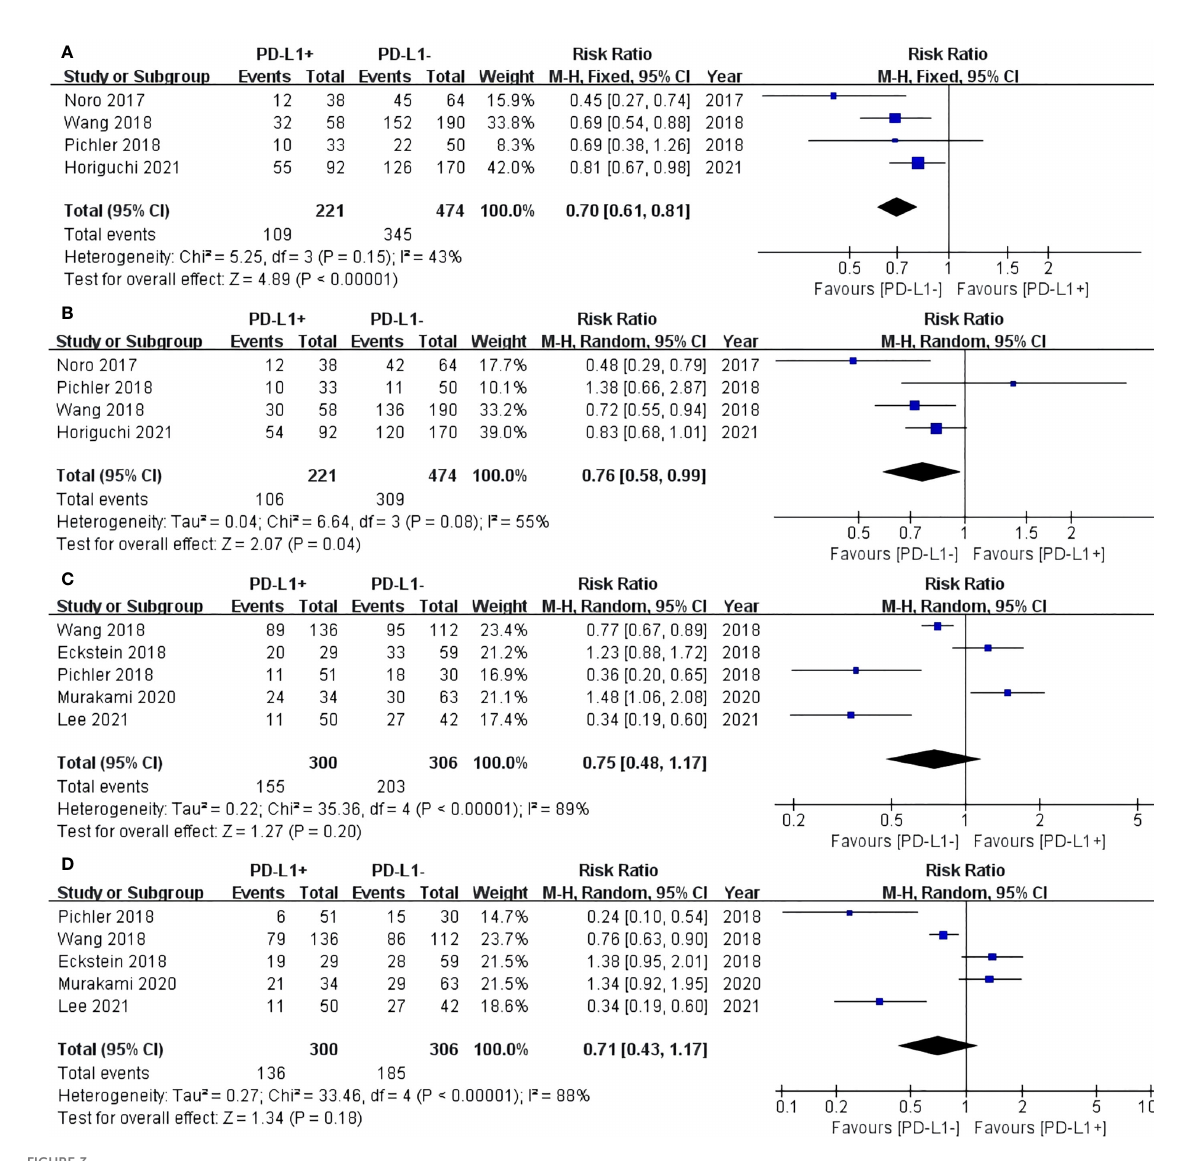
FIGURE 3 Forest plot of recurrence-free survival (RFS) between two group in TCs: RFS after surgery 3 years (A) and 5 years (B) . Forest plot of RFS between two group in ICs: RFS after surgery 3 years (C) and 5 years (D)